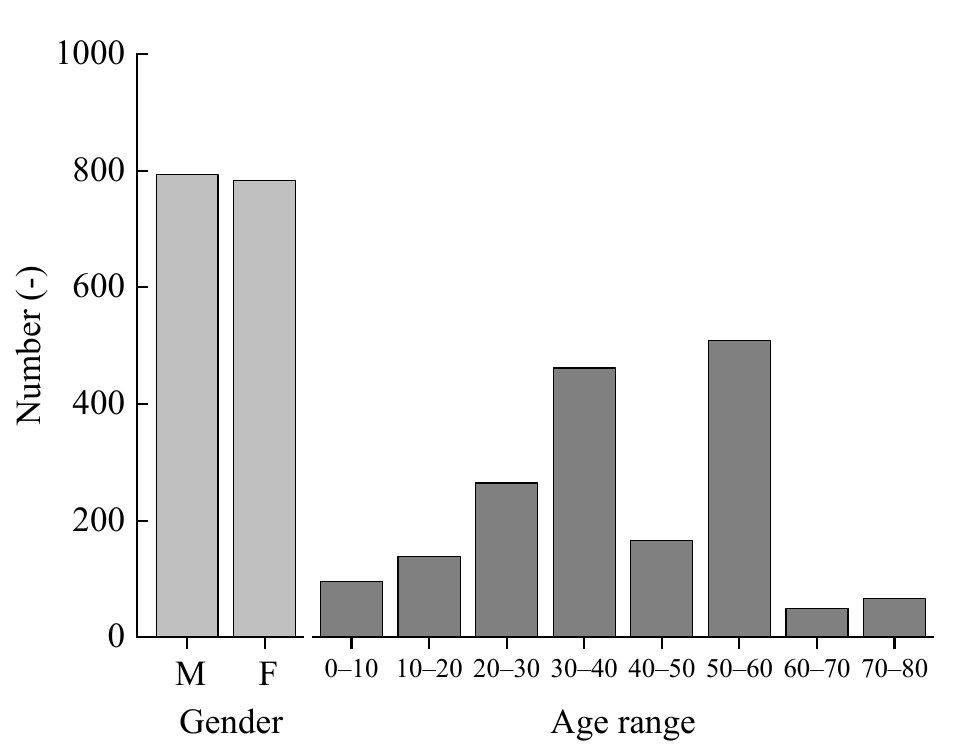
Figure 3. Distribution of occupants by gender and age. Table 5. Statistical summary of thermal environment data and thermal comfort indices.